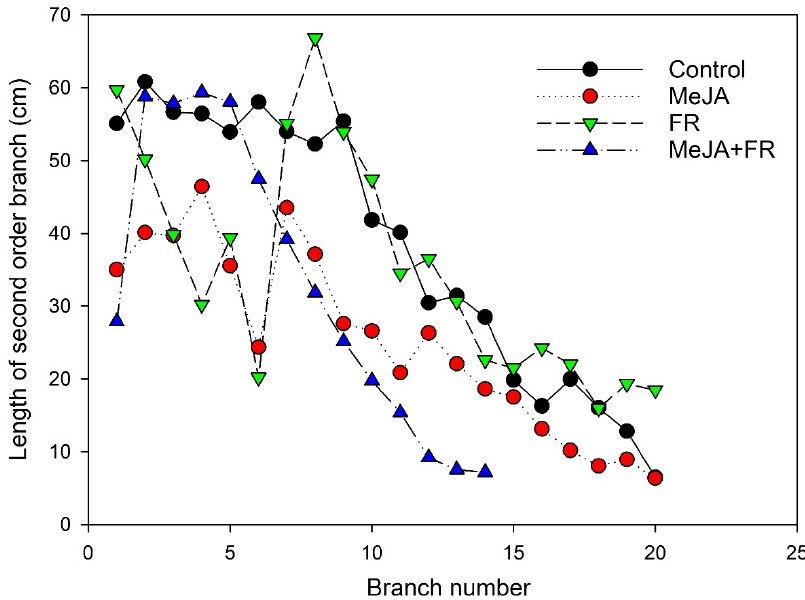
Figure 2. The effect of far-red light and methyl jasmonate (MeJA) application on the length of secondary order branches of Hypericum perforatum ( n = 6). The branch lengths were measured at 64 DAS.